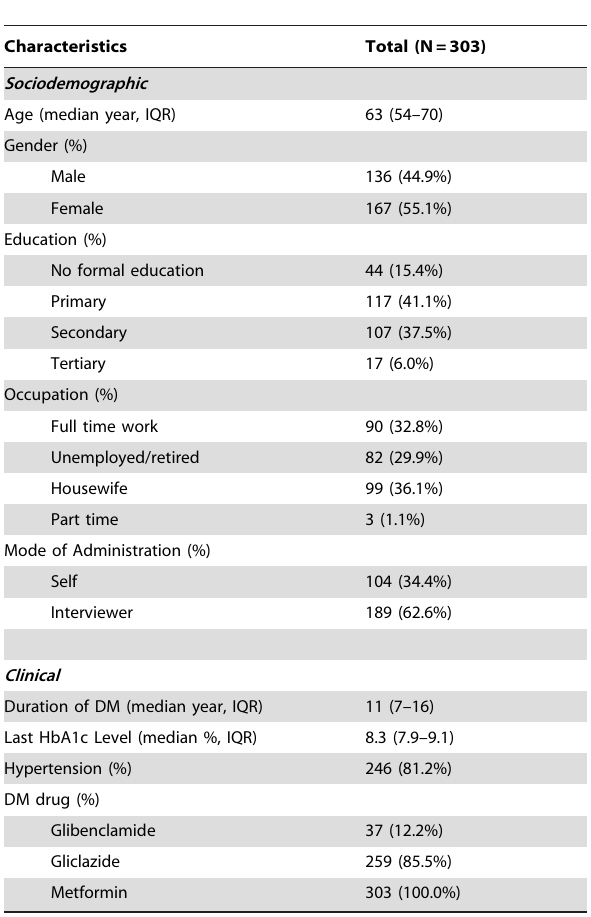
Table 2. Sociodemographic and Clinical Characteristics of Type 2 Diabetes Patients at